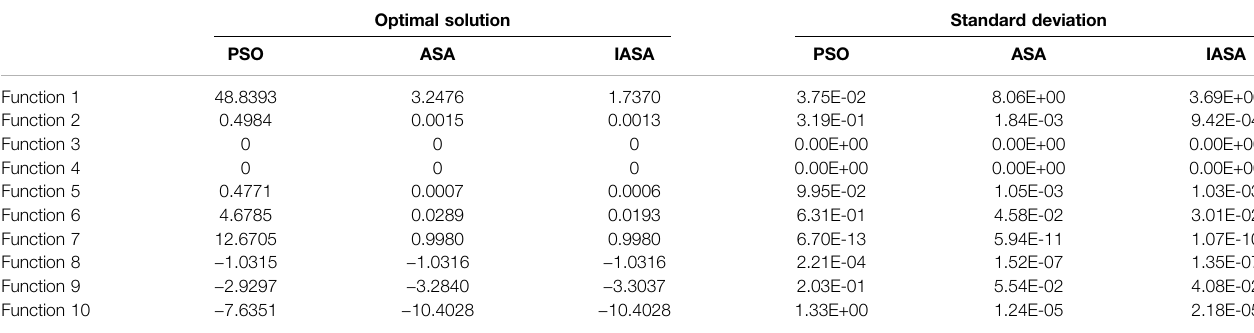
TABLE 1 | Performance comparison of the three optimization